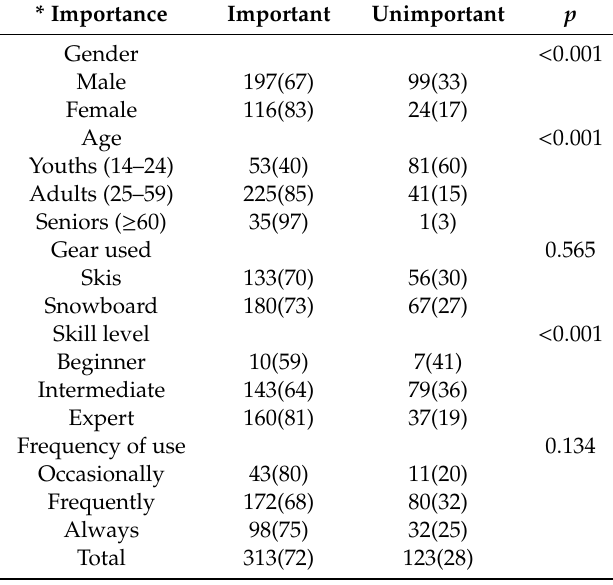
Table 5. Perceived importance of rules among survey